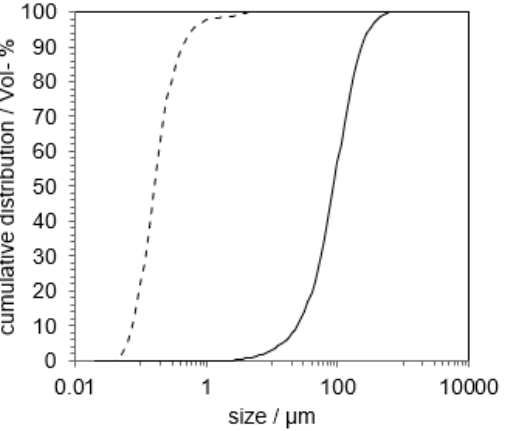
Figure 4. Cumulative particle size distribution of indomethacin suspension before (–) and after milling (- - -). Measured via laser diffraction. An aliquot of both, the microsuspension and the nanosuspension, was placed sepa- rately onto a Kofler-bench. In case of the nanosuspension the color changes to yellow after exceeding 110 °C; in case of the microsuspension this happens after reaching 140 °C. Sam- ples of both experiments were taken at 120 °C and analyzed via XRD. The Kofler bench, the sampling positions and the resulting diffractograms are shown in Figure 5.